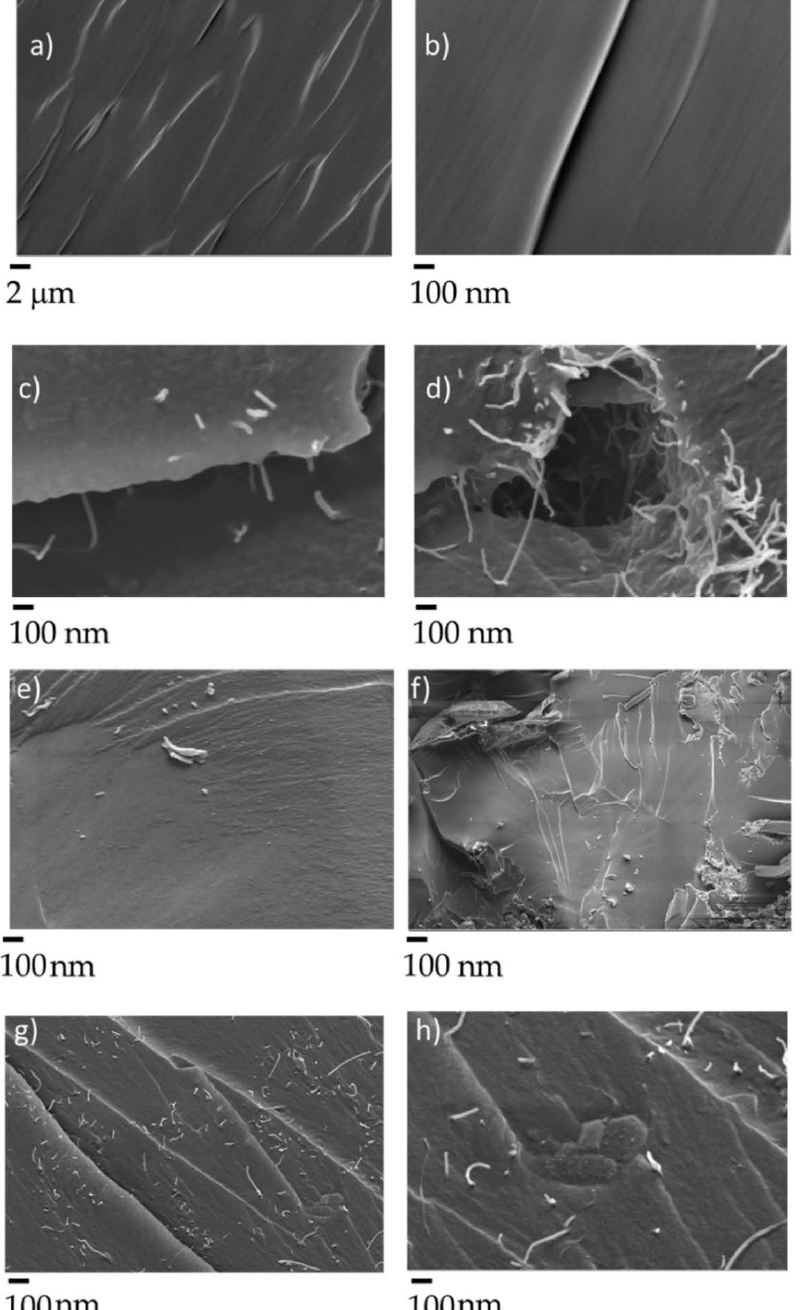
Figure 5. FESEM captures of UV-LED cured films (filler loading: 1 wt%): unfilled EB150 ( a , b ); EB150 + MWCNTs ( c , d ); EB150 + biochar ( e , f ) and EB150 + biochar/MWCNTs ( g , h ). All the filled UV-LED cured films show a good dispersion of the two carbonaceous fillers.